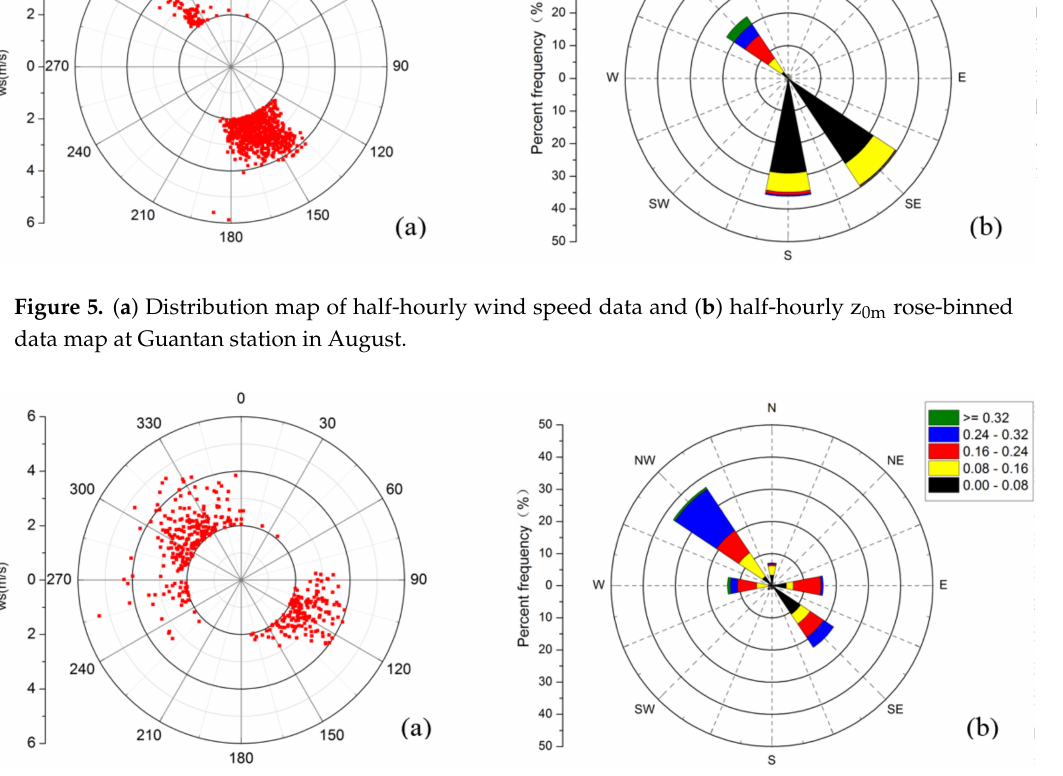
Figure 6. ( a ) Distribution map of half-hourly wind speed data and ( b ) half-hourly z 0m rose-binned data map at Daman station in